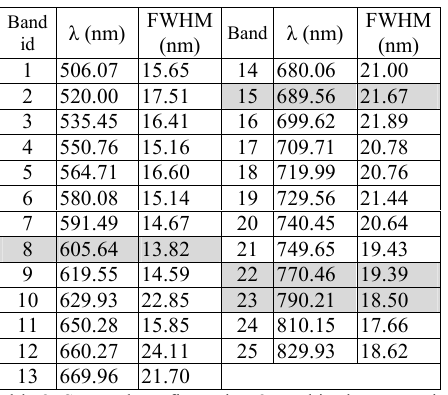
Table 2. Spectral configuration 2 used in the terrestrial calibration (cfg. 2).